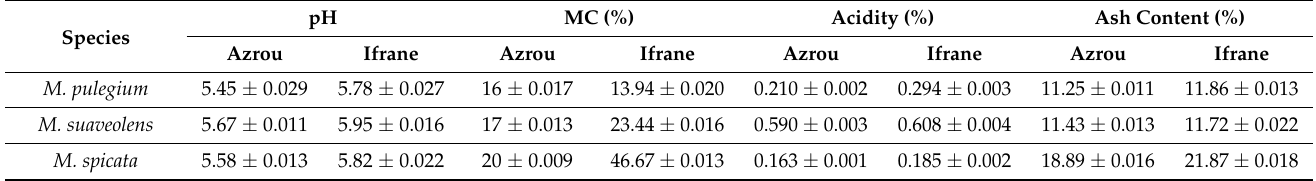
Table 1. Quality control parameters of dry